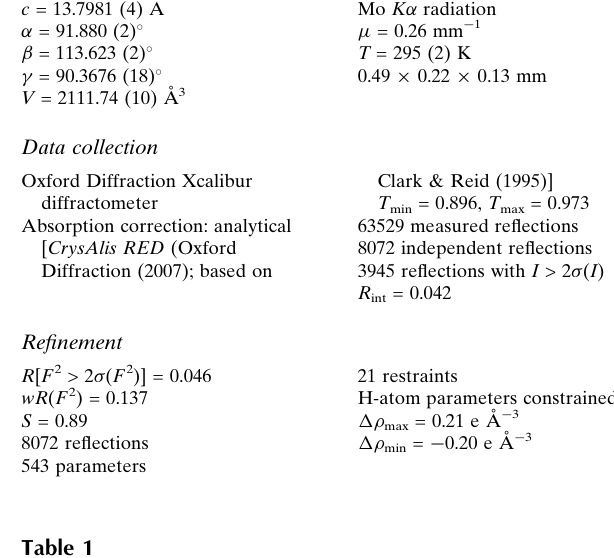
Hydrogen-bond geometry (A˚ , (cid:1)